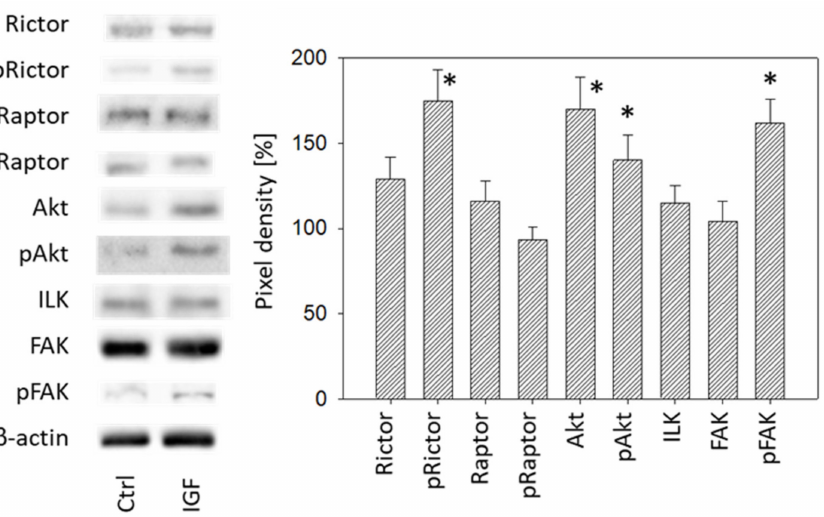
Figure 9. Left: Protein profile of cell signaling proteins. DU145 cells were either stimulated with IGF for 24 h or received culture medium without IGF (Ctrl). One representative of three separate experiments is shown. Each protein analysis was accompanied by a β -actin loading control. One representative internal control is shown. Right: Pixel density analysis of the protein expression level of DU145 cells stimulated with IGF. The ratio of protein intensity/ β -actin intensity is expressed as percentage of controls set to 100%. * indicates significant difference to controls.